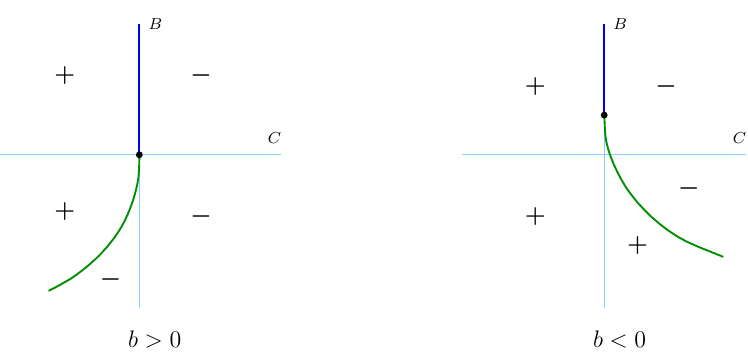
Figure 29 . Phase diagram for Case II: A < 0 , A + a > 0 . The solid blue line is a second order phase transition between the − and + phases. The solid green line is a first order phase transition line between the − and + phases.